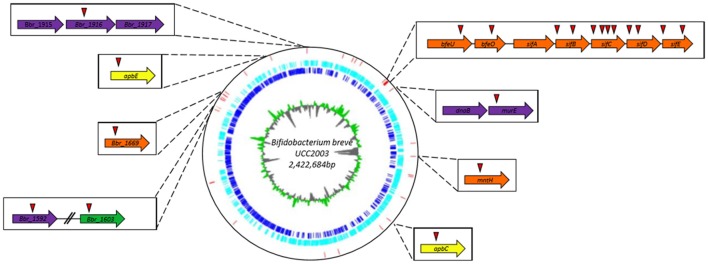
Circular genome map of B. breve UCC2003. The innermost circle illustrates GC skew, shown in green on the forward strand and in gray on the reverse strand. The dark blue circle displays the ORF on the forward strand, while the light blue circle representing all the ORF on the reverse strand. The red vertical bars indicate the transposon insertion sites of dipyridyl-sensitive mutants identified in the screening of the random mutant library. Genes in which transposon mutations were shown to cause complete growth impairment in the presence of either dipyridyl, phenanthroline or ciplopirox olamine are indicated in boxes together with their names or locus tags with the position(s) of the transposon insertion indicated by a red triangle.